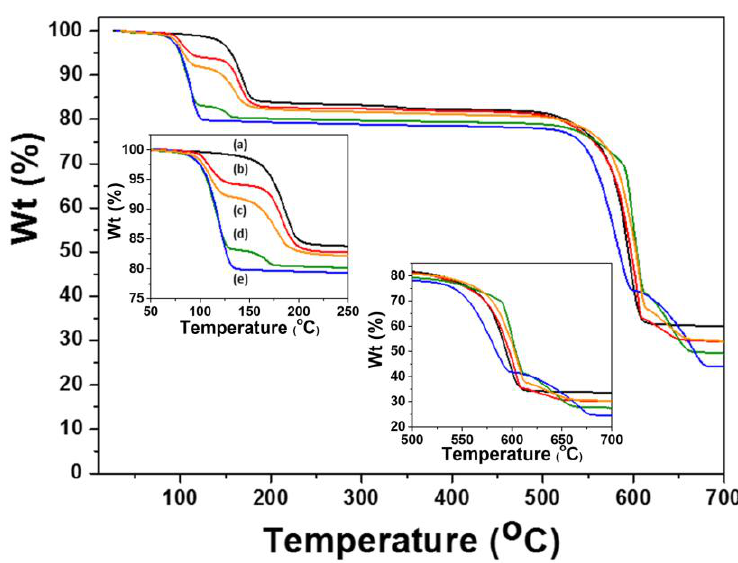
Figure 4. Thermal gravimetric analysis (TGA) curves of thermal property ( a ) Mg-MOF ( b ) Ca 0.6 -Mg 0.4 -MOF ( c ) Ca 0.97 -Mg 0.03 -MOF ( d ) Ca 0.97 -Mg 0.025 Al 0.005 -MOF ( e ) Ca-MOF.